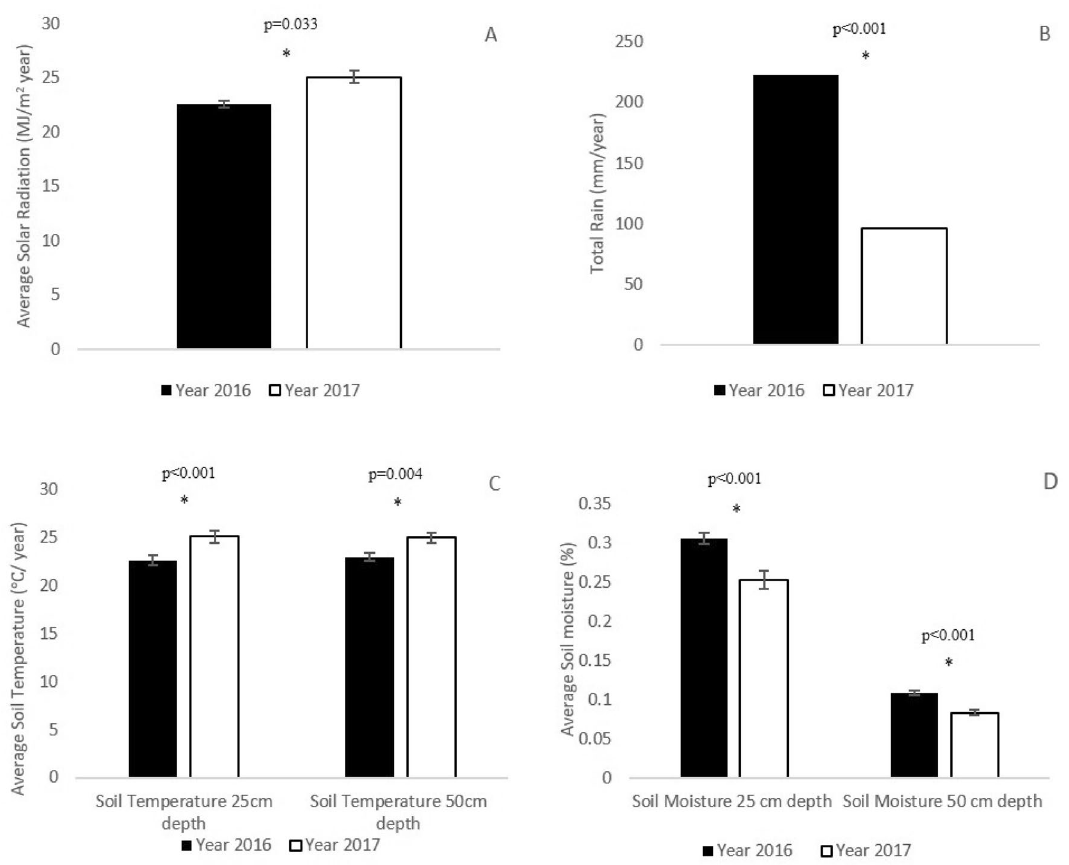
Figure 3. Average solar radiation (± SE) ( A ), total rain ( B ), average soil temperature (± SE) ( C ), and average soil moisture (± SE) ( D ), for 2016 (n = 269) and 2017 (n = 337). For relative trend of meteorological parameters in the period 2000–2015 see SI 1.